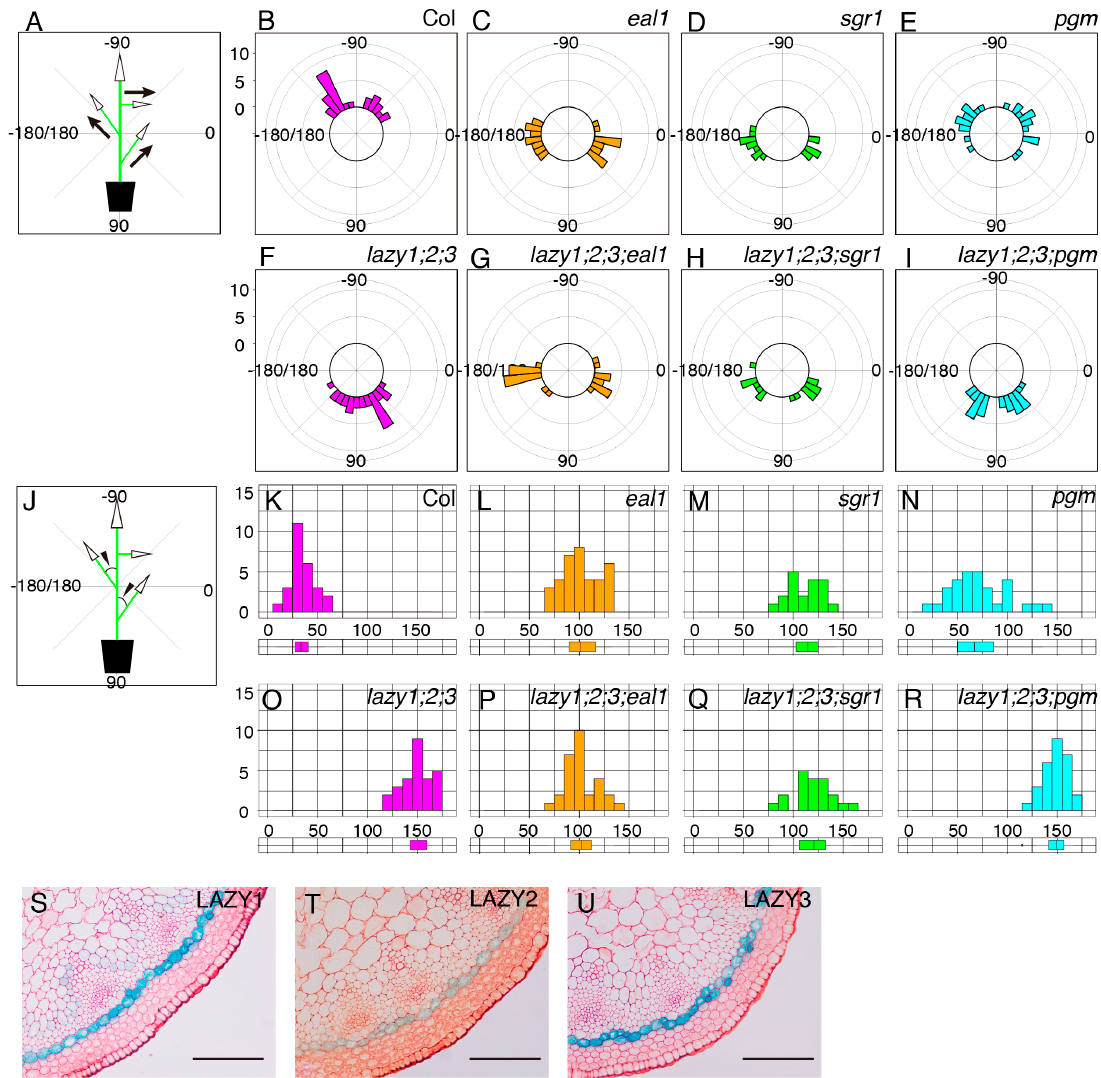
Figure 3. Growth angles of lateral branches. Schematic representation of growth angle evaluation for posture of lateral branches ( A ) and differences from the vertical main axes ( J ). Growth angles of lateral branches from wild-type Col ( B ), eal1 ( C ), sgr1 ( D ), pgm ( E ), lzy1;2;3 ( F ), lzy1;2;3;eal1 ( G ), lzy1;2;3;sgr1 ( H ), and lzy1;2;3;pgm ( I ). Distribution of differential growth angles from the primary flower stem from wild-type Col ( K ), eal1 ( L ), sgr1 ( M ), pgm (N), lzy1;2;3 ( O ), lzy1;2;3;eal1 ( P ),